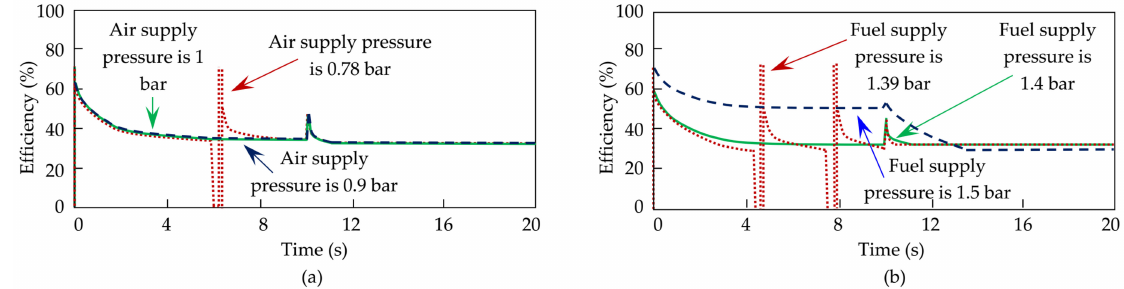
Figure 14. E ffi ciency for di ff erent: ( a ) air pressures; and ( b ) fuel pressures.